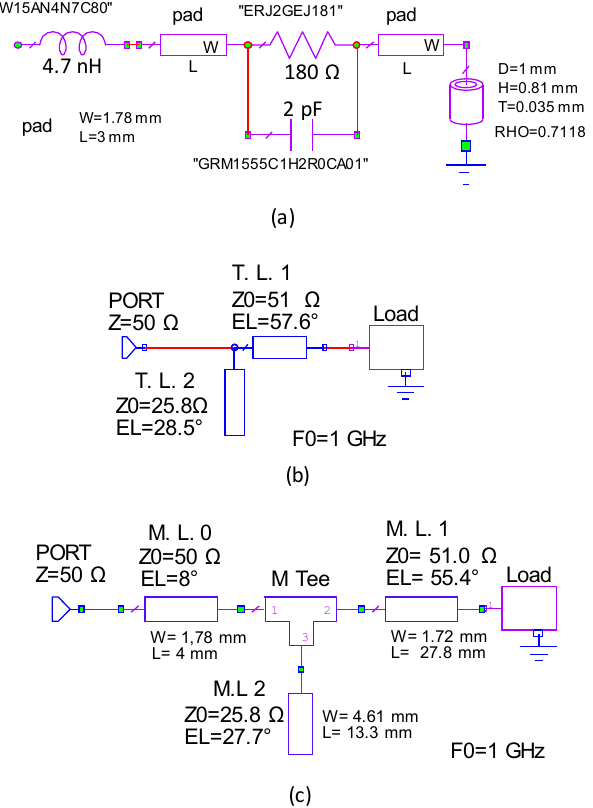
Figure 5. Schematics of the realized circuit with relevant parameters: ( a ) circuit of the load; ( b ) trans- mission line (T.L.) model of the matching network; ( c ) compensated microstrip line (M.L.) model of the matching network.